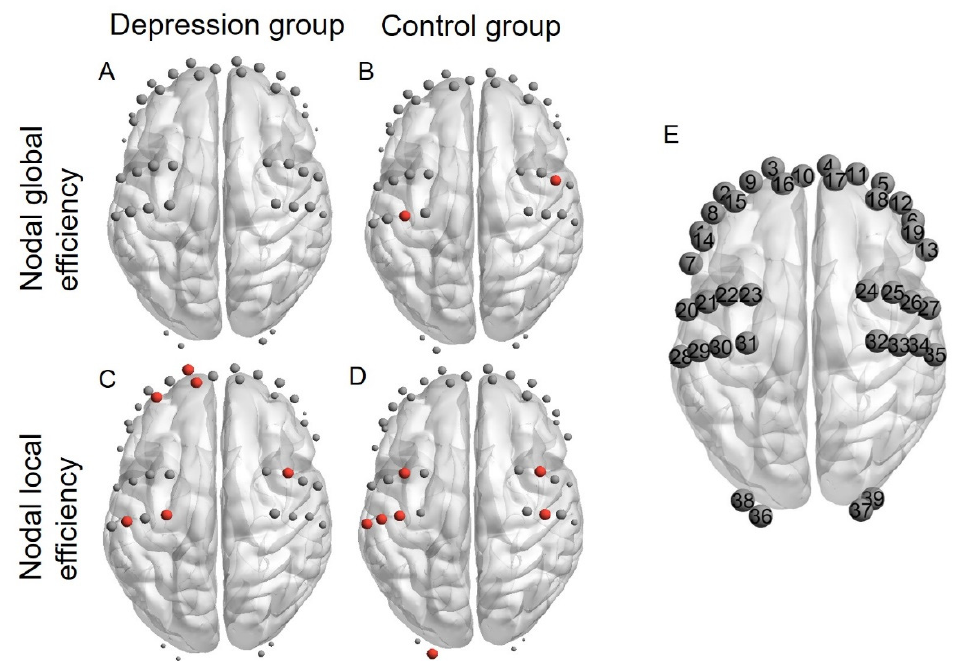
Figure 5. Regional nodal properties and hub distributions in the depression and control groups. Each dot means a single channel, and red dots represent hubs (see Methods). Panels ( A , B ) depict nodal global efficiency in the depression and control groups, respectively; panels ( C , D ) denote the nodal local efficiency in the depression and control groups, respectively. ( E ) Numbered channels for clarity.